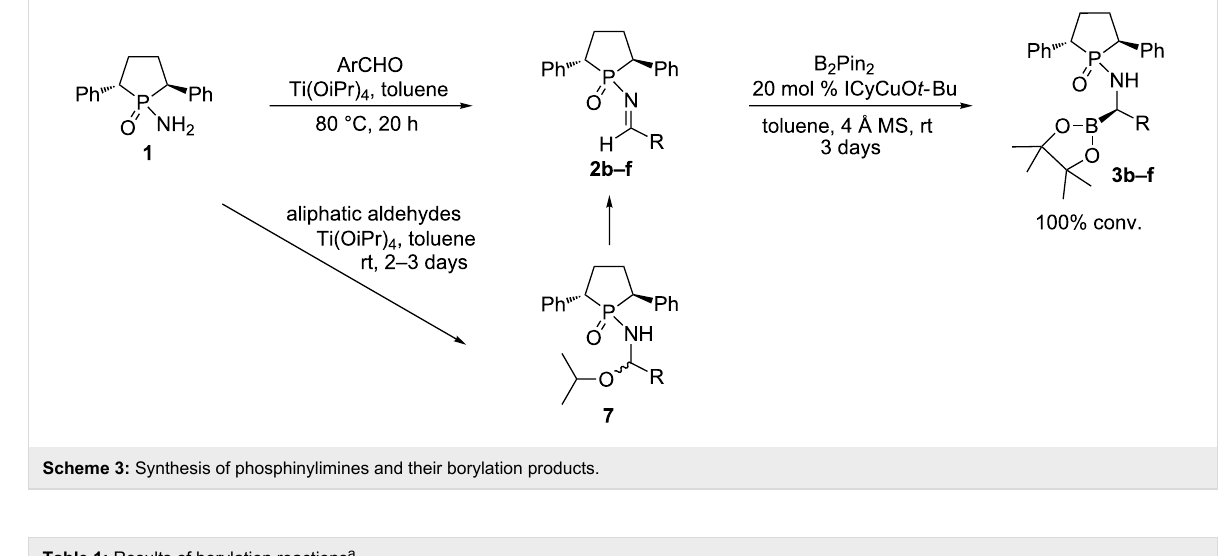
Table 1: Results of borylation reactions a .